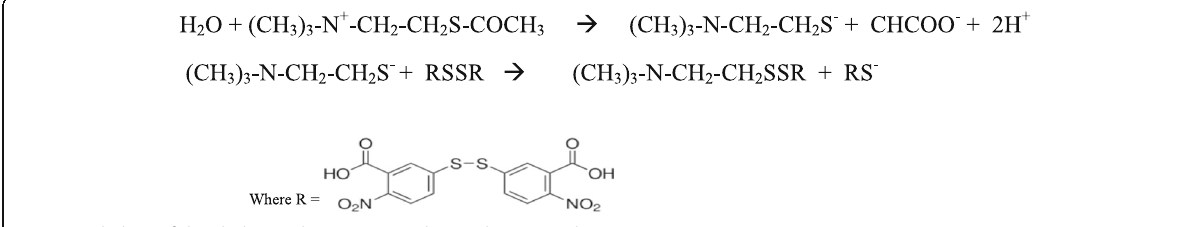
Fig. 3 Hydrolysis of thiocholine with DTNB to produce 5-thio-2-nitro benzene